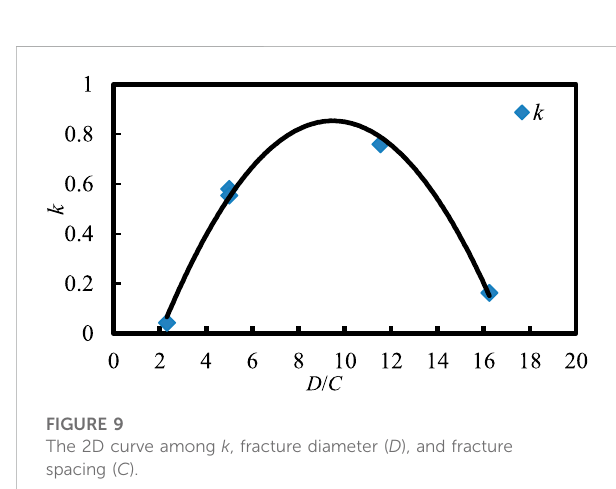
The 2D curve among k , fracture diameter ( D ), and fracture spacing ( C where L is the ratio of D to C ; and R 2 is the relative coef fi cient. Equation 5 is a standard quadratic polynomial function. Here, R 2 can reach 0.99273, which means that k has a reasonably high